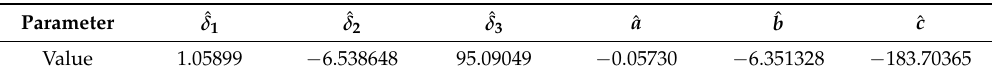
Table 2. Value of the parameters of the GWFM model with sequence W ( 0 )